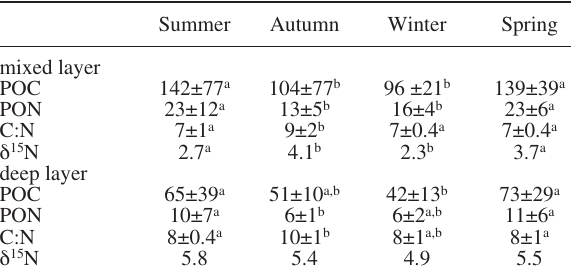
Table 1. – Seasonal means (±SD) of concentrations of particulate organic carbon (POC, mg L -1 ) and nitrogen (PON, mg L -1 ),